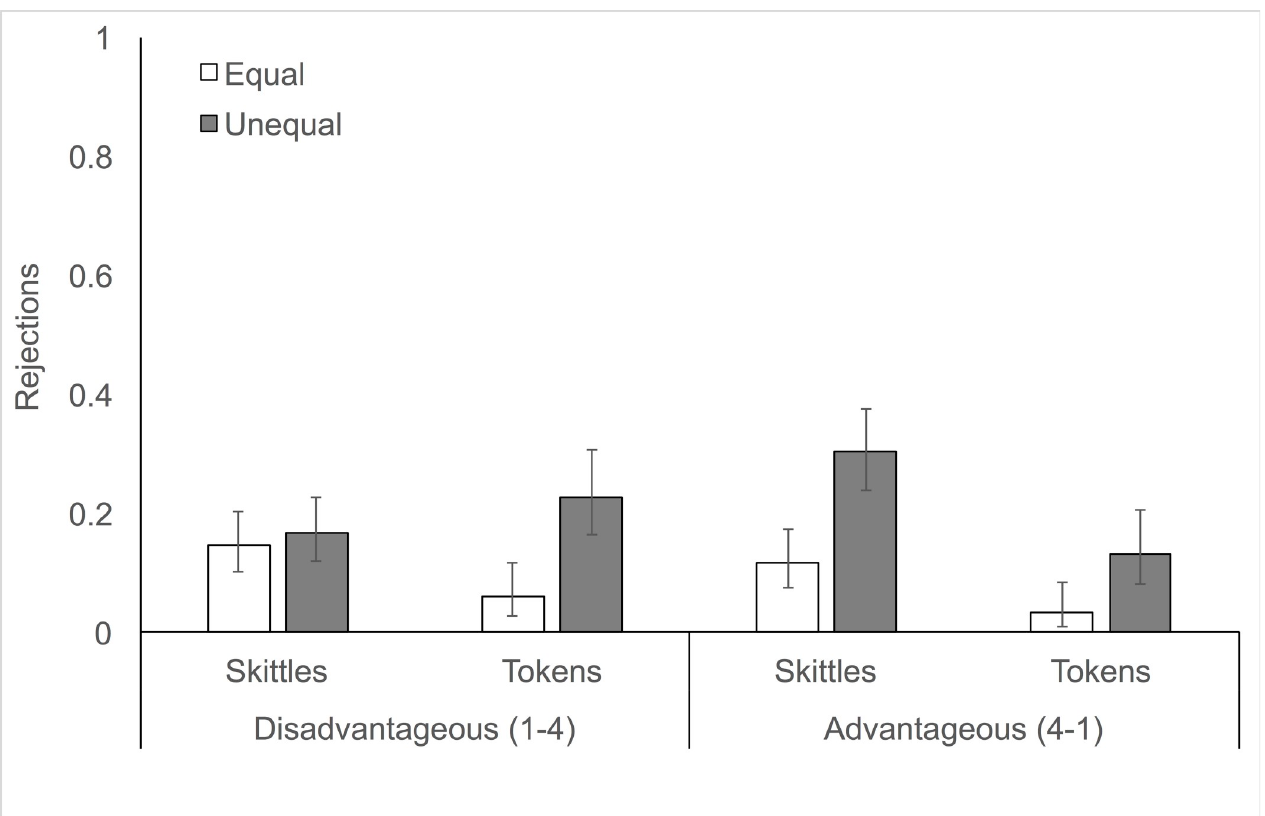
Fig 2. Proportion of rejections of equal and unequal allocations in disadvantageous and advantageous conditions. Rejections are shown by reward type. Error bars show binomial confidence intervals.